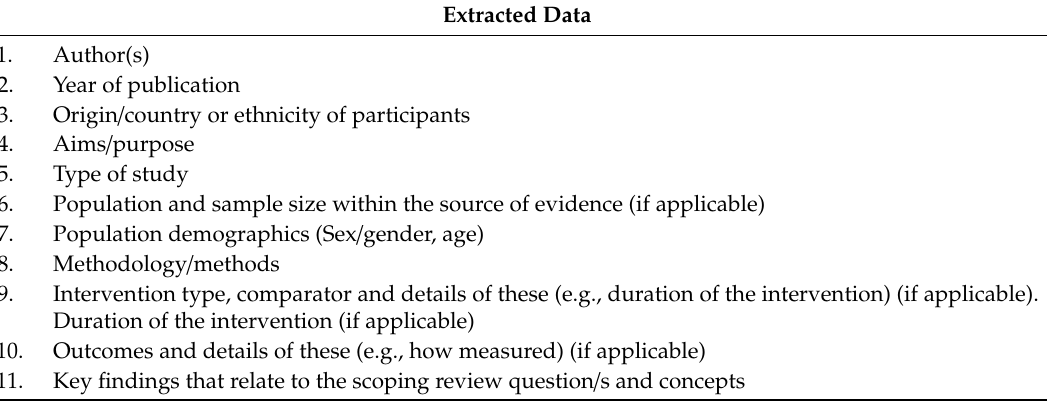
Table 2. List of information extracted from each full-text article meeting inclusion